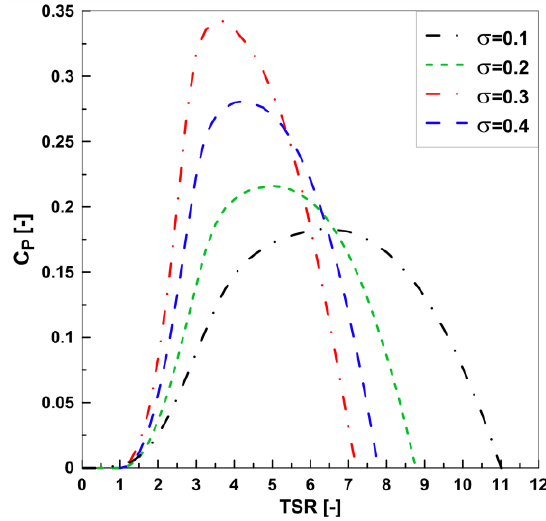
Figure 11. Performance curve for different solidity